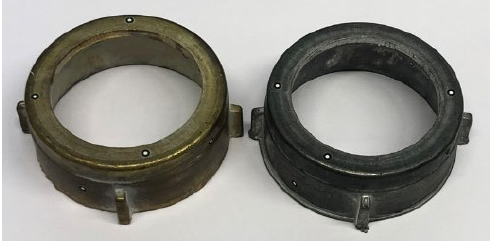
Figure 8. Wet rotor head made of CuZn39Pb3 (left) and of ZEP1510 (right).